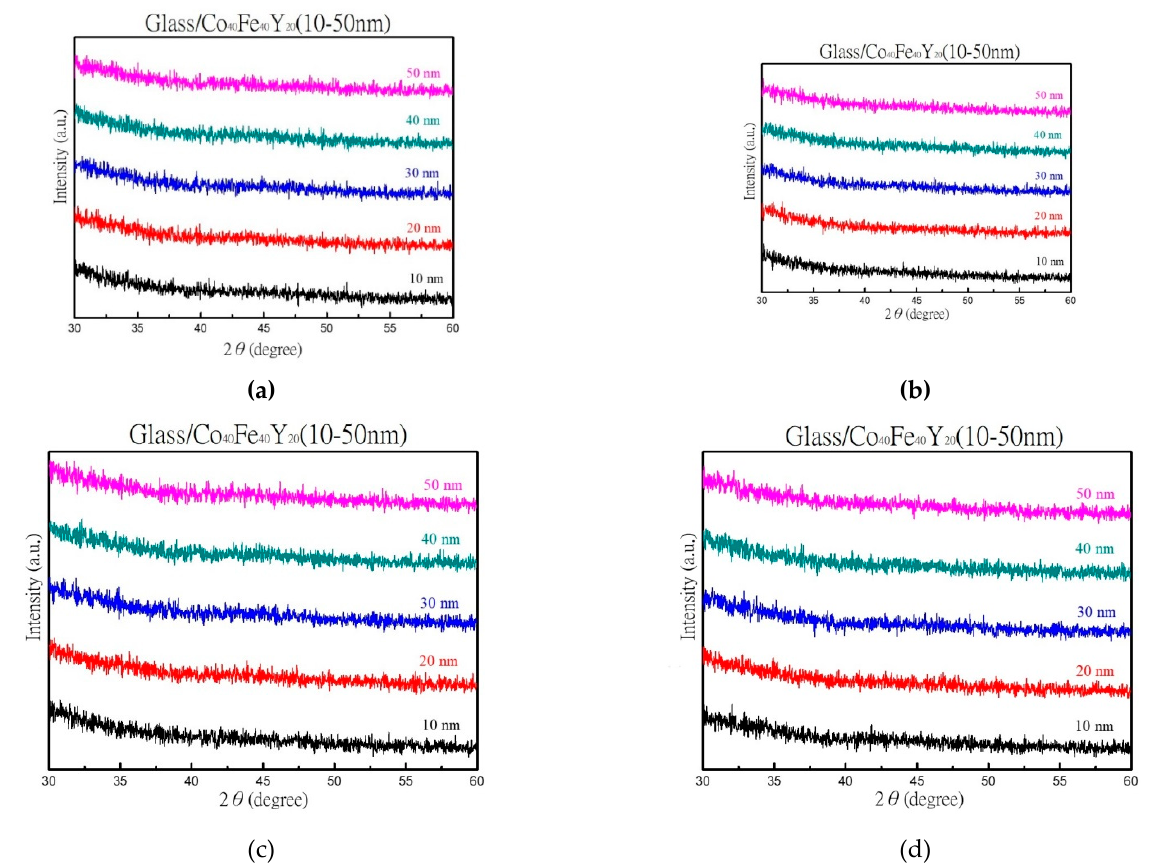
Figure 1. XRD pa tt erns. ( a ) RT, ( b ) after annealing at 100 °C, ( c ) after annealing at 200 °C, ( d ) after Figure 1. XRD patterns. ( a ) RT, ( b ) after annealing at 100 ◦ C, ( c ) after annealing at 200 ◦ C, ( d ) after annealing at 300 °C. annealing at 300 ◦ C.